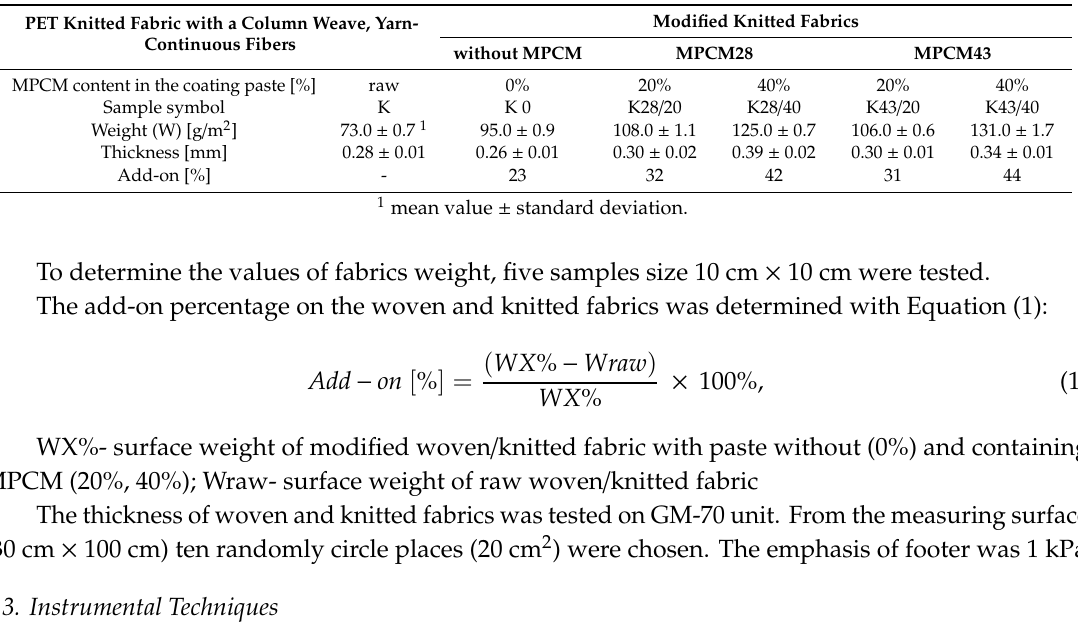
Table 5. Characteristics of knitted